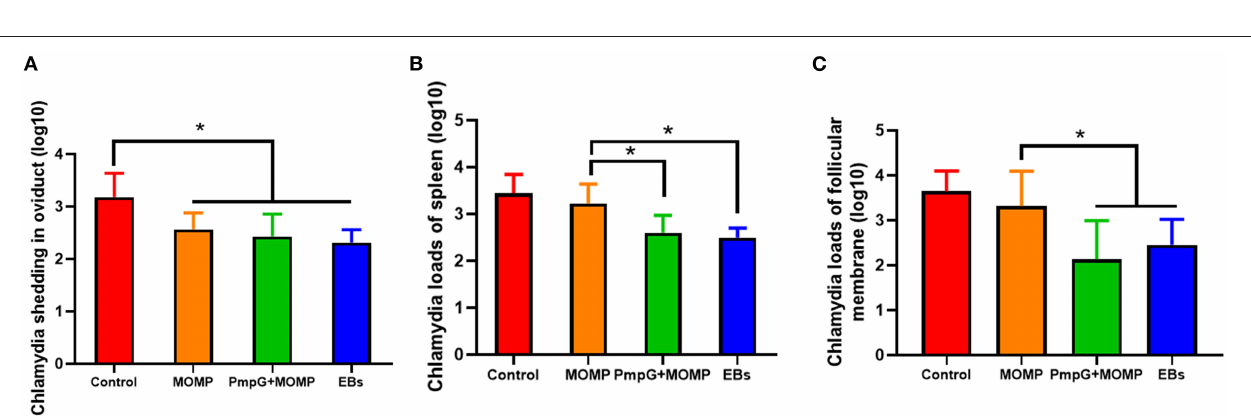
FIGURE 8 | Lesions of follicles and oviducts post-Chlamydial challenge in breeder ducks. (A) Follicular lesions were significantly decreased in the PmpGs + MOMP group and the inactivated EBs group compared with the commercial MOMP group or the control group ( p < 0.05). (B) Oviduct lesions were obviously reduced in the PmpGs + MOMP group compared with the control group. The differences were analyzed by ANOVA (* p < 0.05).